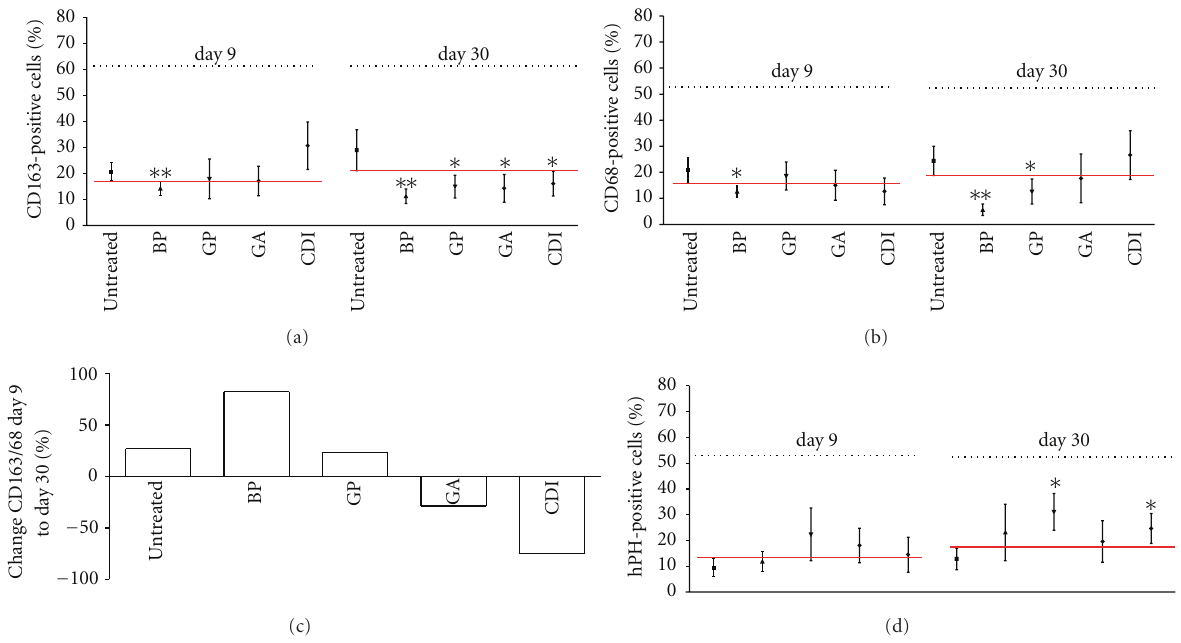
Figure 6: Immunohistological analysis of the degree of sca ff old infiltration by CD163 (a), CD68 (b), and hPH-positive fibroblasts (d) after 9 and 30 days, as well as the CD163/CD68 ratio (c). At day 30 postimplantation, a decrease of infiltrating CD163-positive macrophages could be observed in all implants compared to untreated sca ff olds. Furthermore, a decrease of infiltrating CD68+macrophages could be observed in the BP group, as well as after cross-linking with GP compared to untreated sca ff olds at day 30. Untreated and cross-linked sca ff olds, except the CDI and GA groups, showed a macrophage M2 phenotype switch at day 30 postimplantation, indicated by a positive CD163/CD68 ratio at day 30 compared to ratio at day 9. All data were represented as ratios of specific cells/total cells ± SEM. Five microscopic fields (magnification × 1000) of one slide per rat were analyzed ( n = 3 per group and day). An average of 75 ± 2 . 15 total cells per microscopic field was counted to generate the ratio of cells/total cells. All implants were compared by means and confidence interval to the untreated implant. Di ff erences were considered as significant if confidence intervals do not overlap or by P < 0 . 05, see red line. Untreated: untreated sca ff old; BP: bovine pericardium (St. Jude, USA); GP: genipin; GA: glutaraldehyde; CDI: carbodiimide; hPH: hydroxyl-prolyl-hydroxylase. ∗ P < 0 . 05, ∗∗ = P < 0 . 01 versus untreated decellularized esophagus